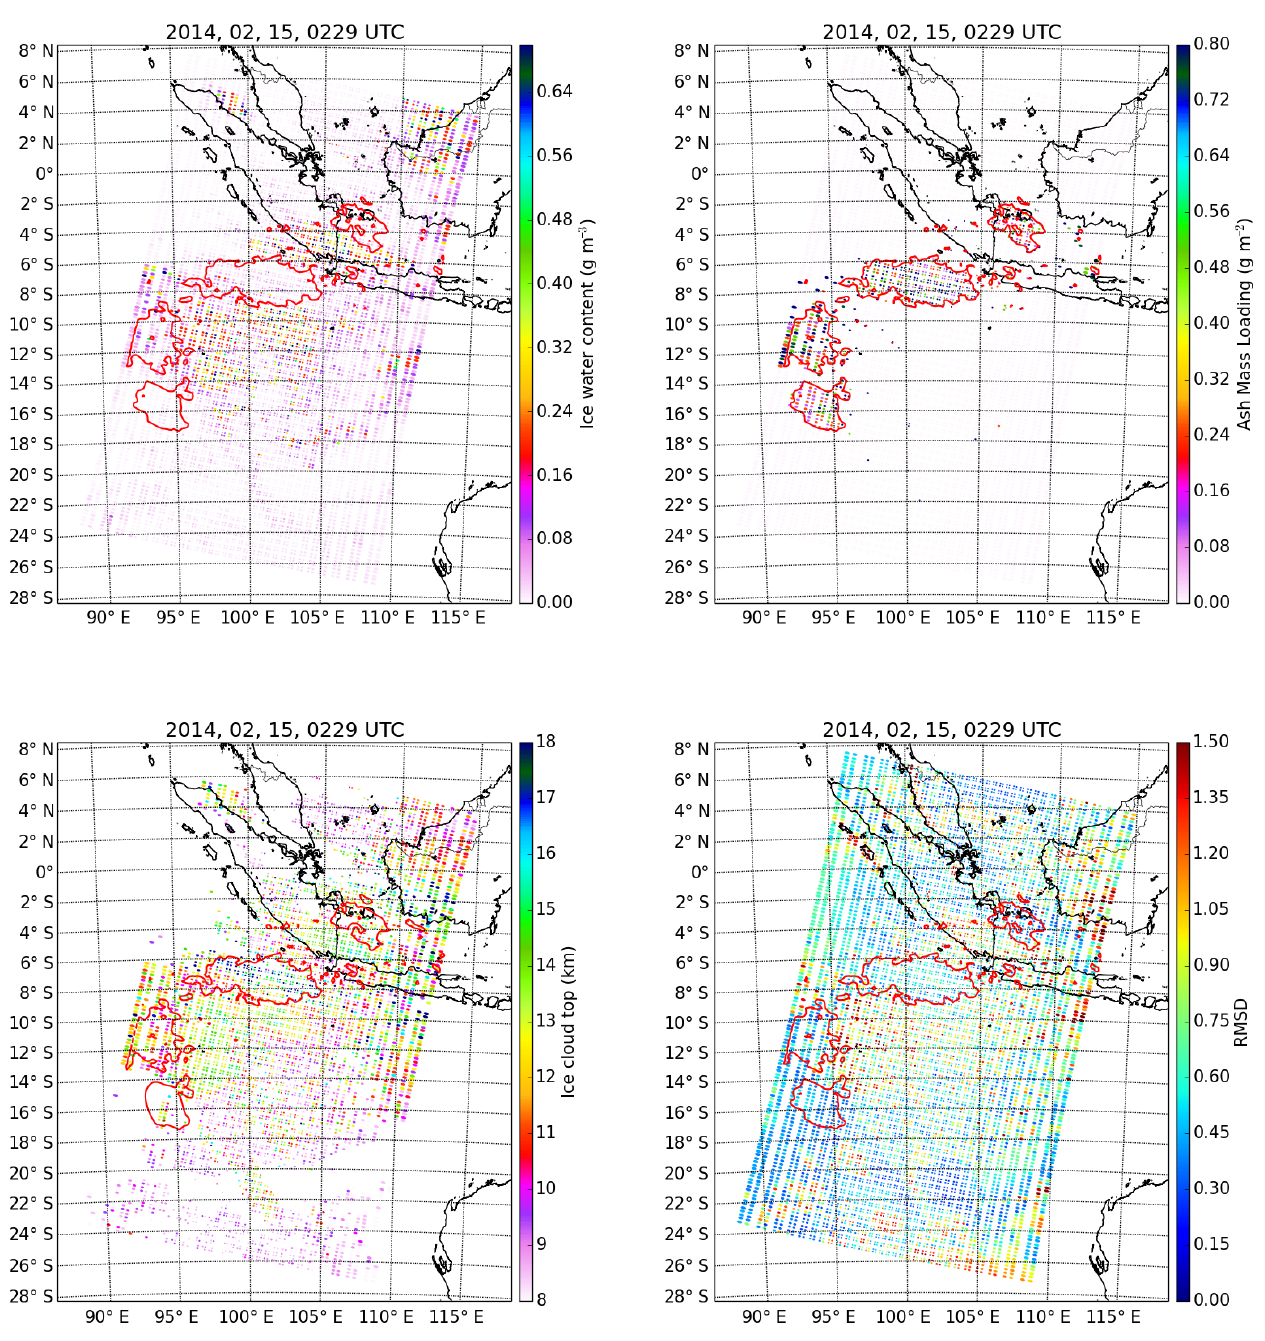
Figure 9. (Upper left panel) The estimated ice water content. (Upper right panel) The estimated ash mass loading. (Lower left panel) The estimated altitude of the ice cloud top. height for ice clouds with ice water content > 0.01gm − 2 . (Lower right panel) The root mean square difference (RMSD) of the simulated-measured spectra. The red contour line delineates the area identified as ash. Data from 15 February 2014,